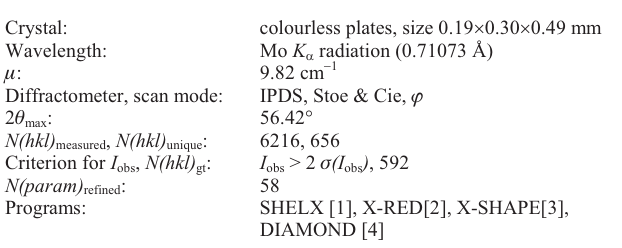
Table 1. Data collection and